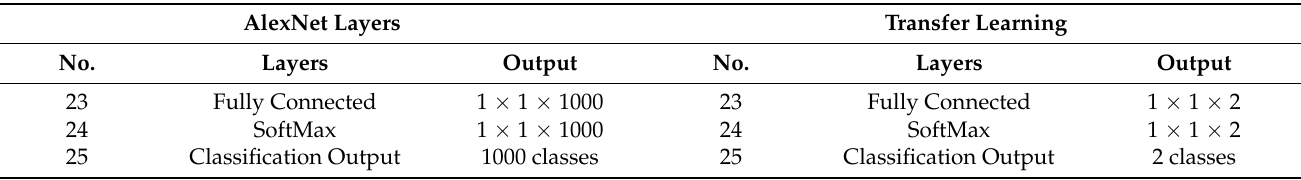
Table 4. Transfer